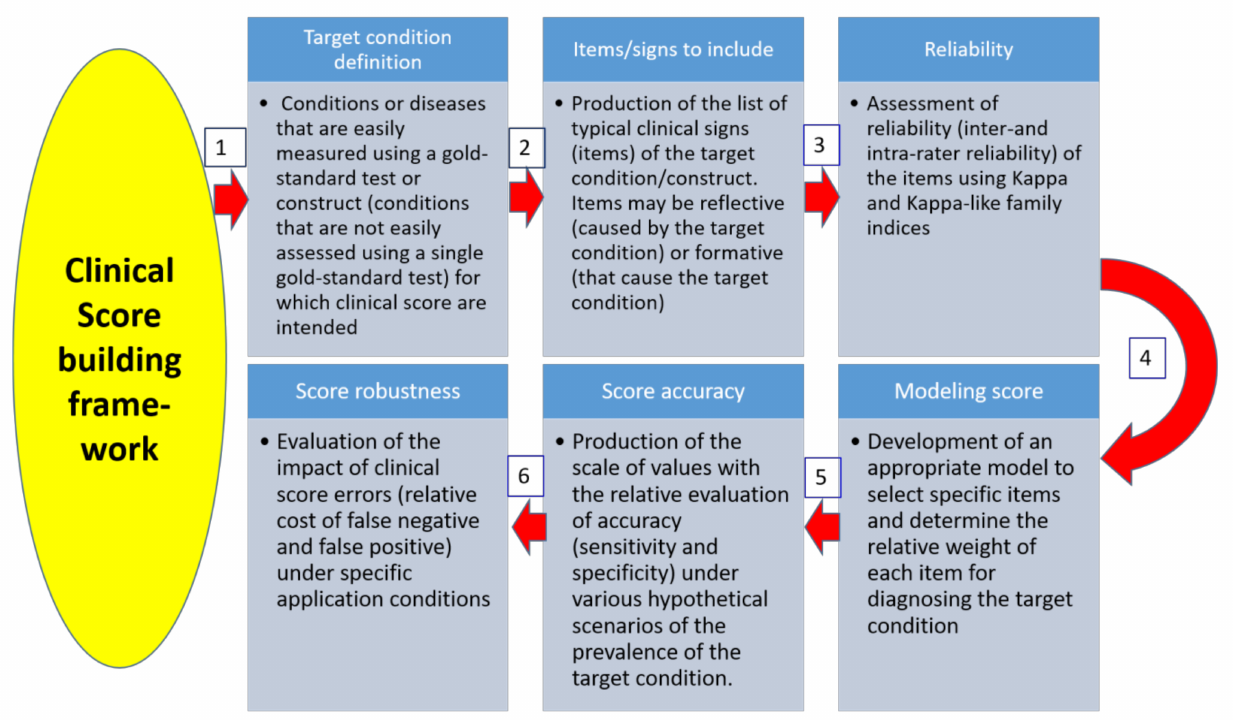
Figure 2. General framework to establish and validate a clinical scoring system in veterinary medicine. Our 6-step framework is depicted with an initial definition of the target condition ( 1 ), the potential items of interest ( 2 ), and their reliability ( 3 ). The modeling approach then determines the adequate repartition between and within item weights ( 4 ). The accuracy of the score is determined in step ( 5 ). The optimal threshold selection is then adapted to the specific conditions where the test is intended to be used ( 6 ). Score users also need to be adequately